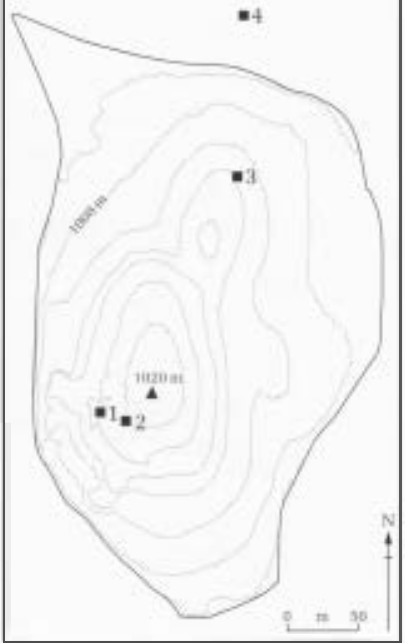
Figure 3 Plan of the east mound at (:atal­ hoyiik showing the location of the excava­ tion areas mentioned in the text. (1) South, (2) Summit, (3) North, (4) Kopal.